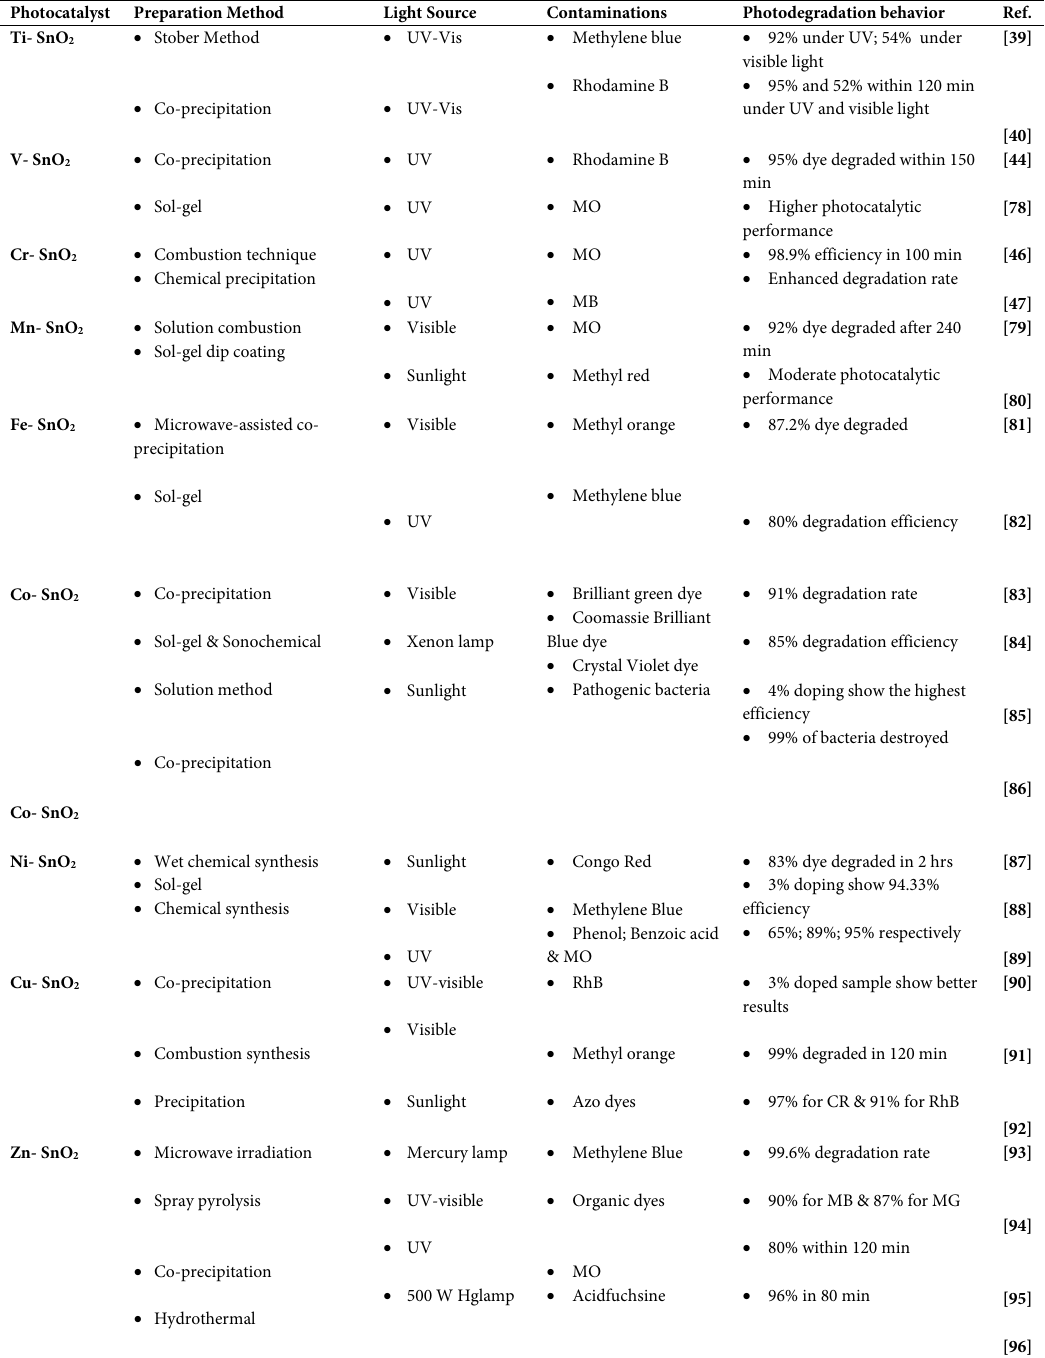
semiconductor material. [MB: Methylene blue, MO: 2 Methylene